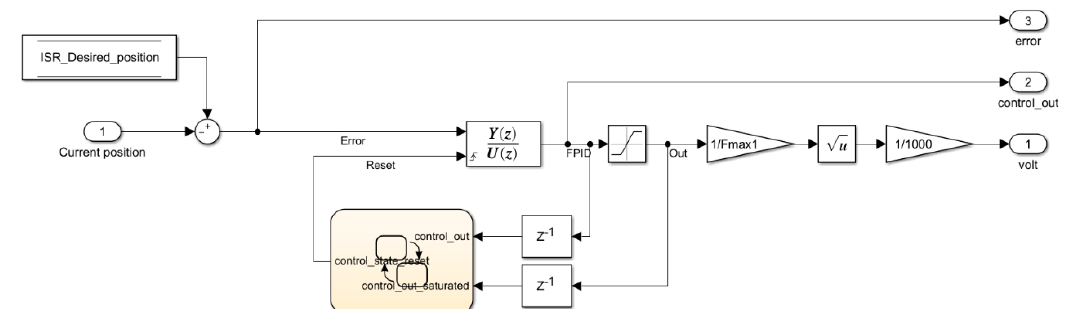
Figure 8. Simulink block inside the ADC_ISR block.